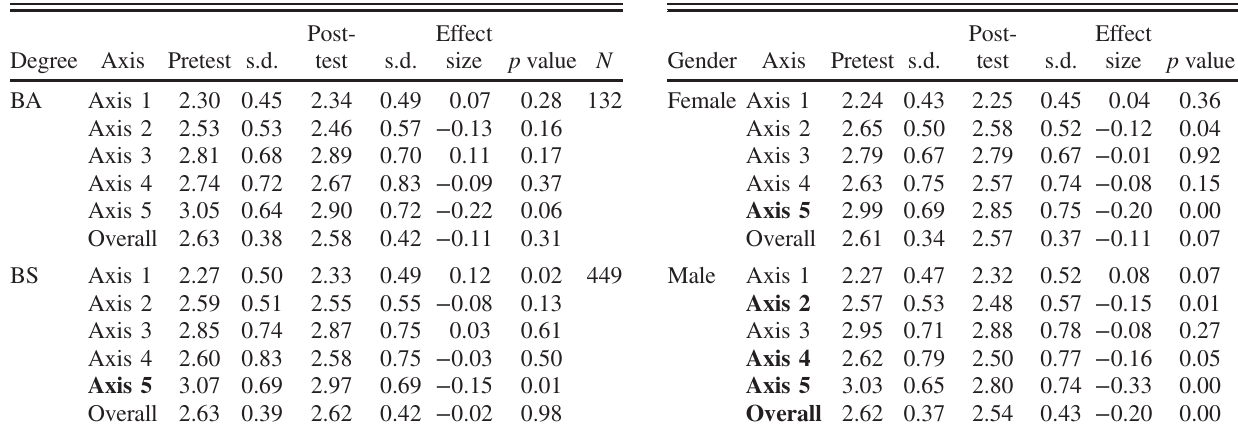
TABLE VIII. EBAPS baseline pretest and post-test results by gender. a